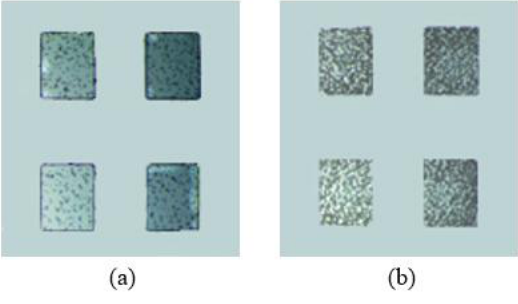
Figure 4. Optical images of ( a ) 40%, 1000 rpm, ( b ) 40%, 4000 rpm samples.